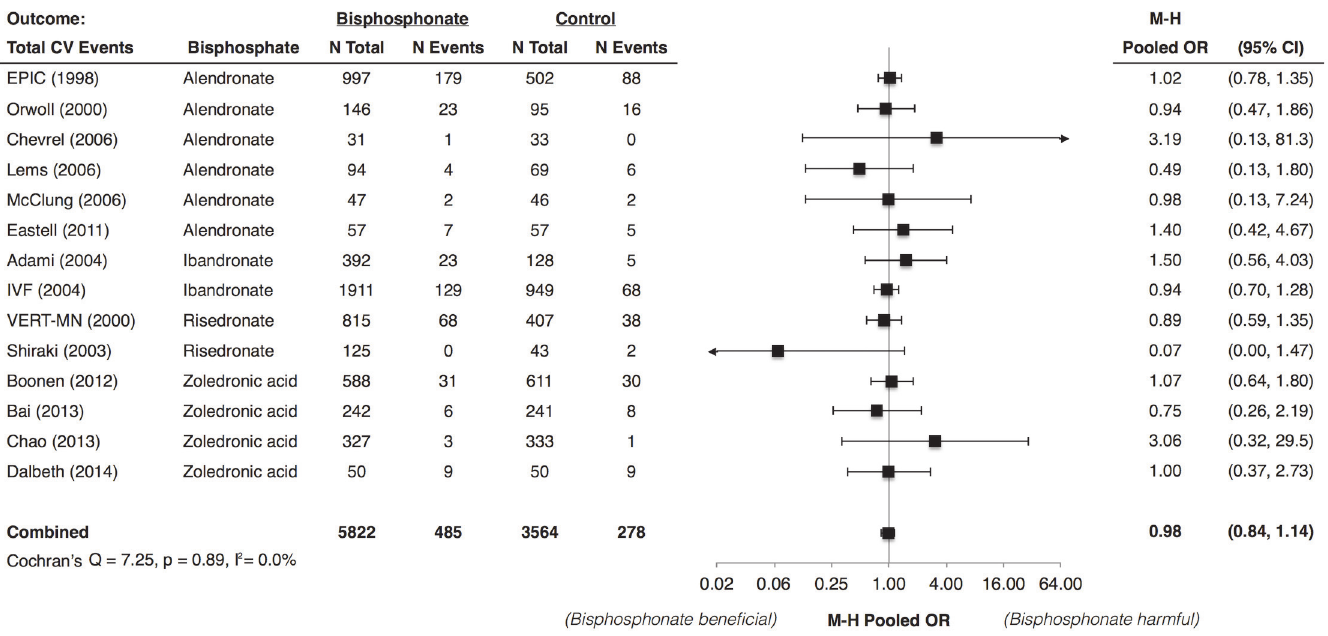
(Table 5 in S1 File). Except serious atrial fibrillation events, our results changed minimally when we re-estimated the pooled ORs after excluding 1 trial at a time. Finally, we did not find any evidence of publication bias by the Begg adjusted rank correlation test and the Egger re- gression test for all 5 outcomes (data not shown). The trim-and-fill method made little differ- ence in the pooled OR (95% CI): 0.98 (0.83, 1.14) for total CV events; 1.08 (0.93, 1.26) for atrial